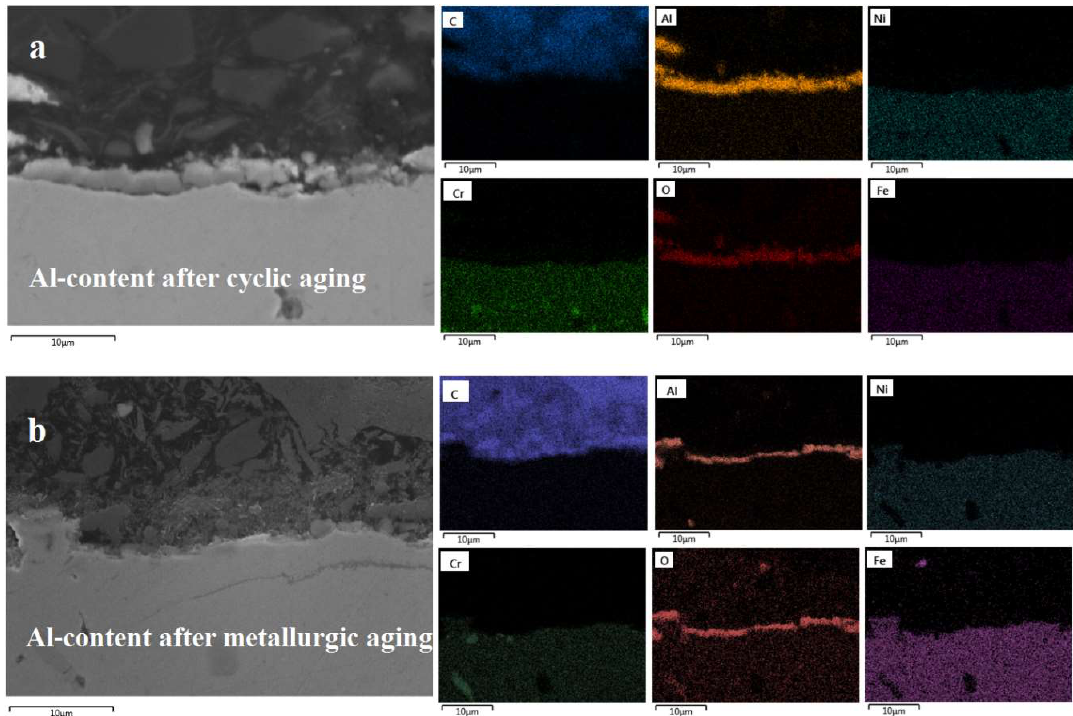
Figure 8. SEM-EDX images of an Al-containing alloy after cyclic aging ( a ) and after metallurgic aging ( b ). Magnification: 3000×, Accelerating Voltage: 15 kV.